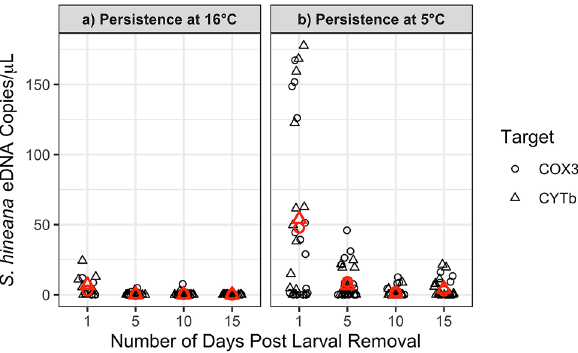
Figure 2. Significant decrease in S. hineana eDNA concentrations at 16 °C (p < 0.01) and 5 °C (p < 0.001) between 1 and 15 days post larval removal. Shape indicates gene target (COX3, CYTb). Red shapes indicate average quantification for each